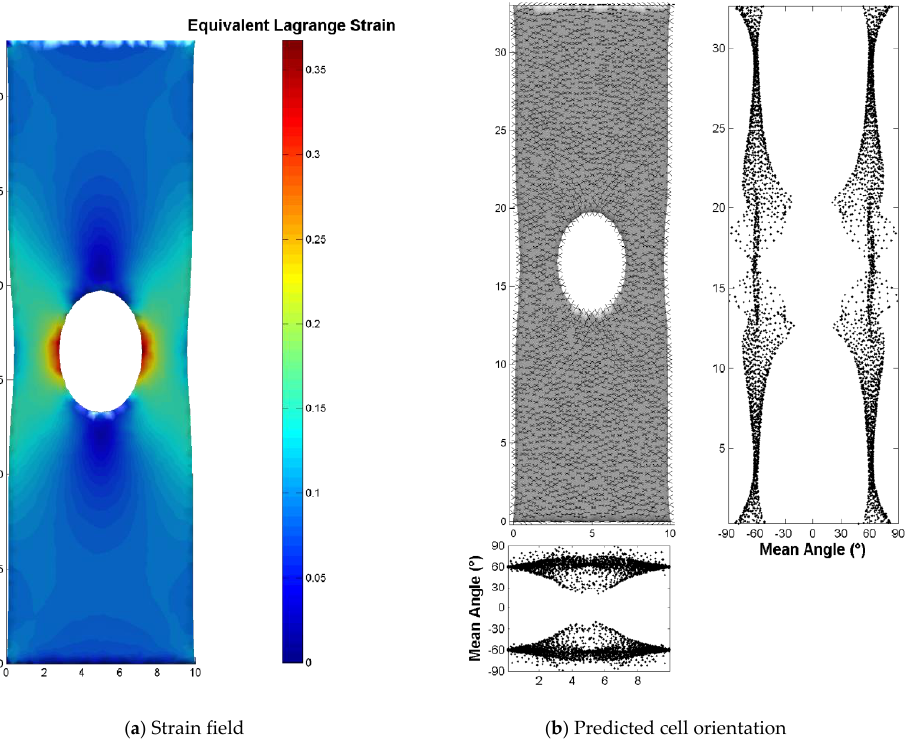
Figure 4. Illustration of the procedure enabling the computation of cell orientation in the case of a complex 2D strain field that is experimentally testable. ( a ) Uniaxial stretch of a perforated membrane leads to a heterogeneous strain field in the neighborhood of the hole; ( b ) Mirror-image angles are heterogeneously distributed on the membrane surface. Bioengineering 2017 , 4 , 16